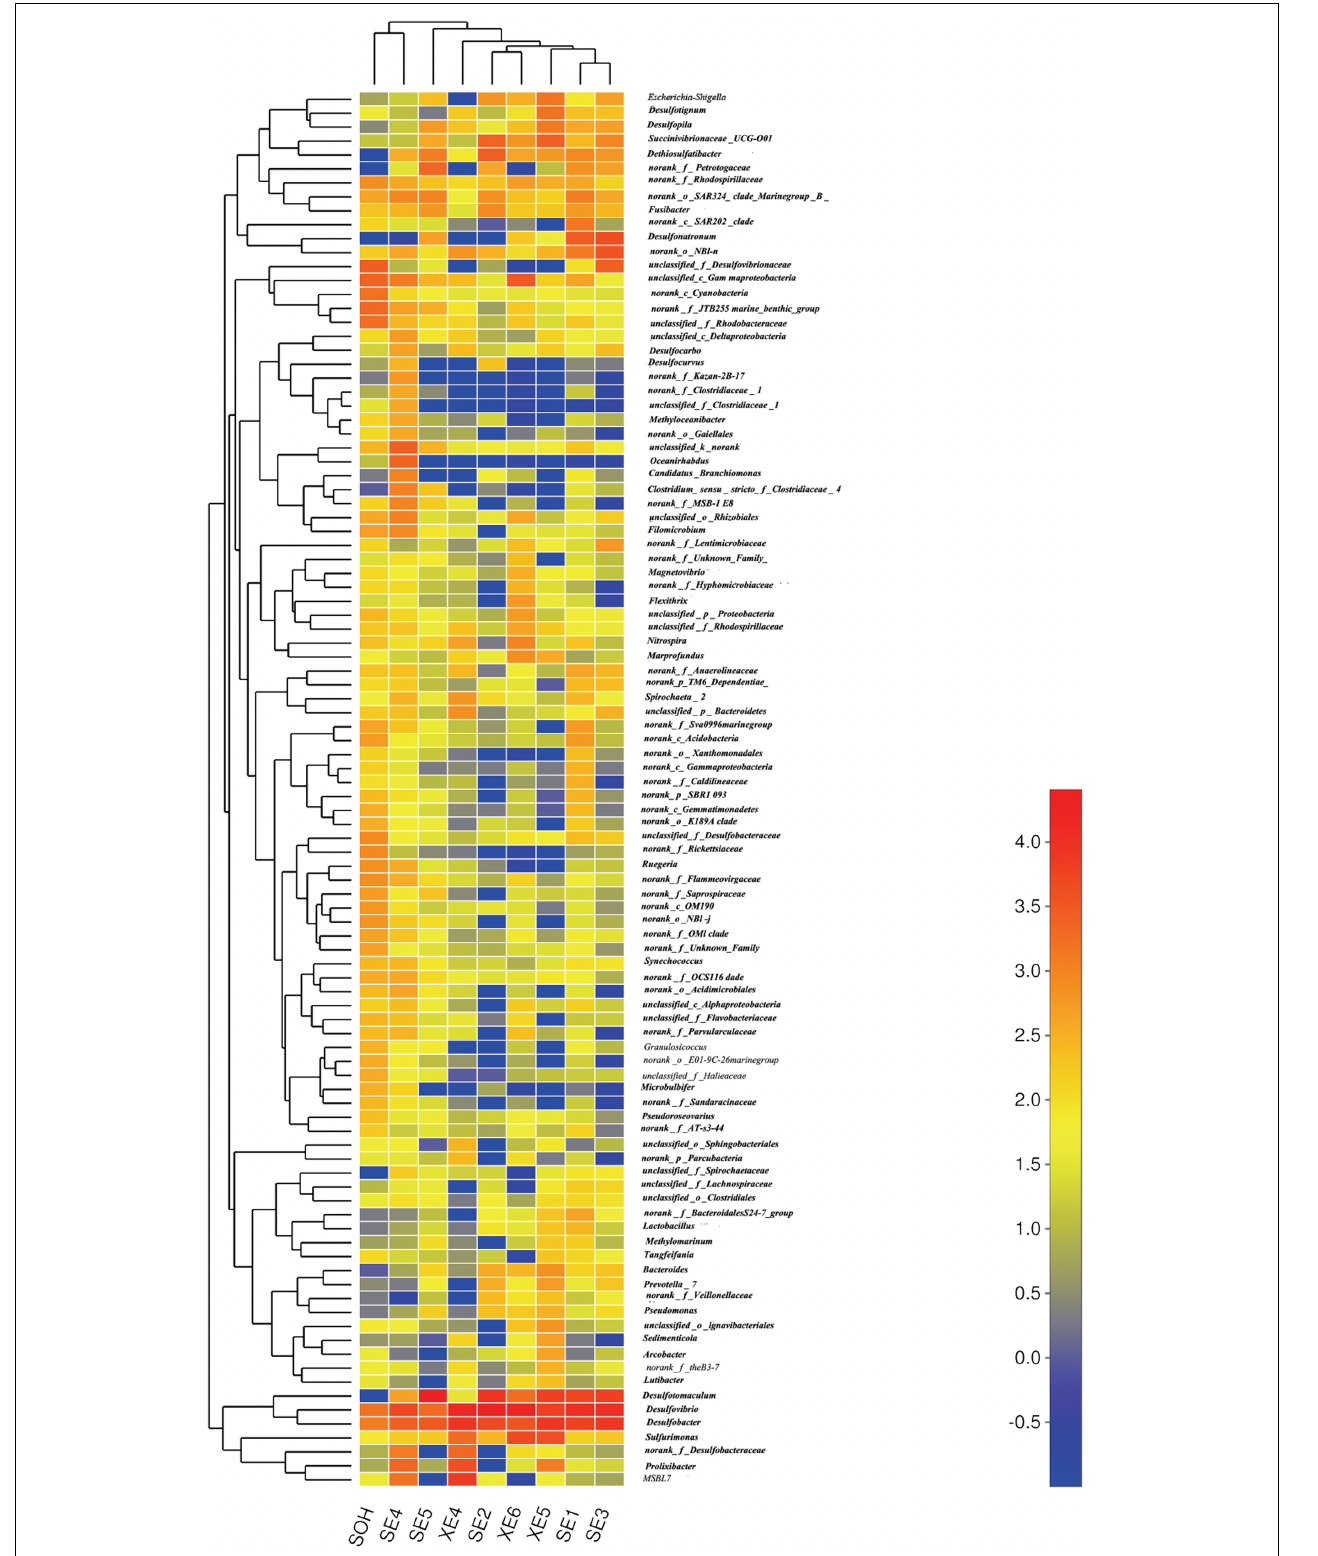
FIGURE 8 | The bacterial community distributions among the nine corrosion samples at the genus level.